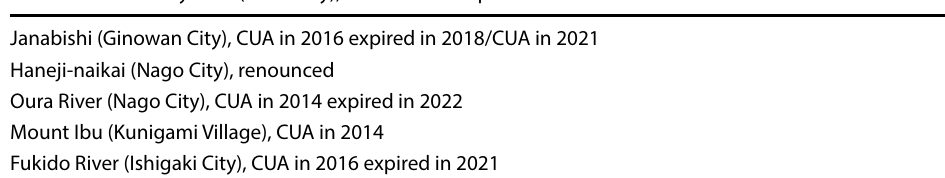
Table 4 Model areas chosen in the project